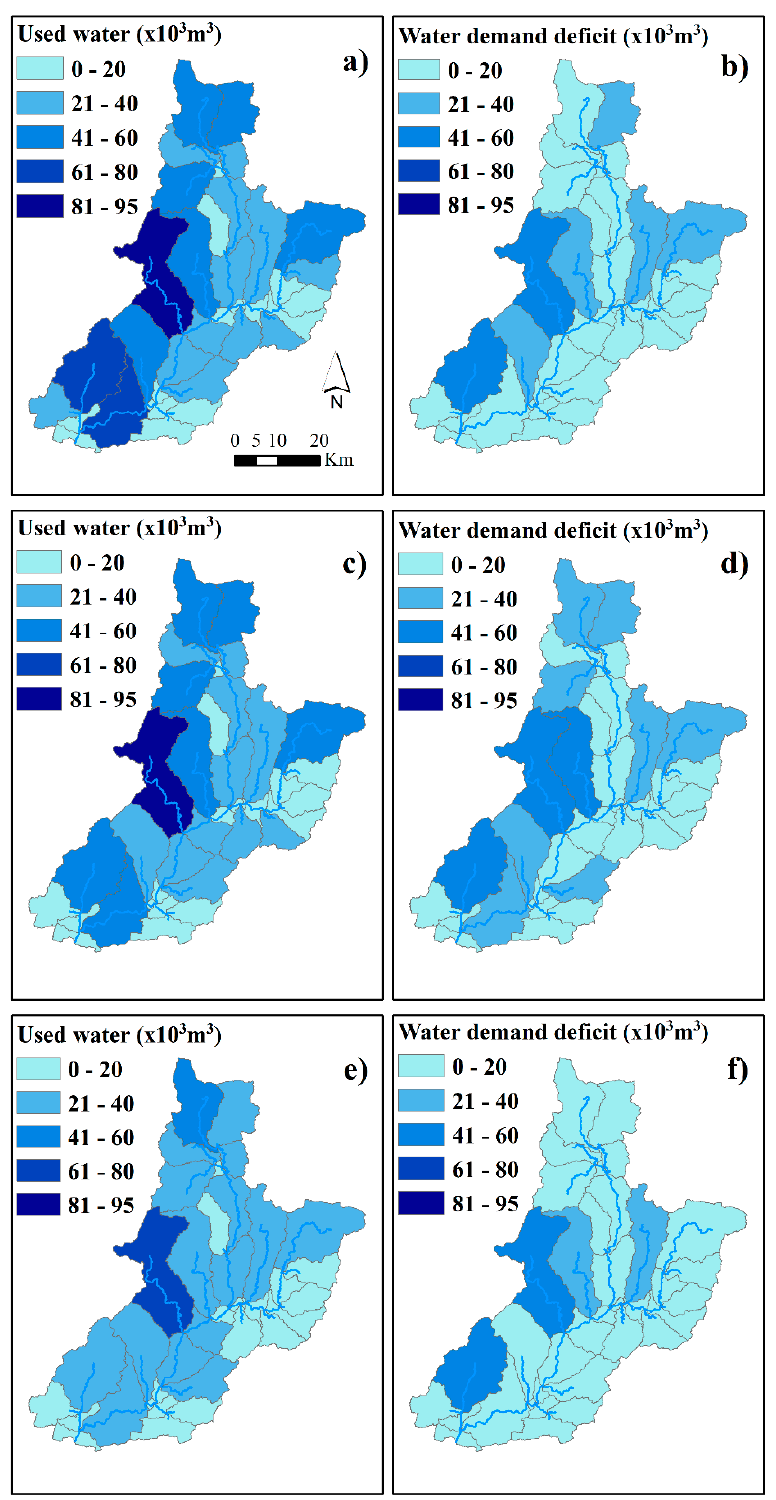
Figure 7. The water used for domestic consumption and the water demand deficit at the sub-basin scale in the Sabor River basin. ( a ) and ( b ) represent the water used for domestic consumption and the water demand deficit in the historical view, respectively. The figures ( c ) and ( d ) represent the data on the increase in the irrigated area, and ( e ) and ( f ) represent the data on the scenario of a projection to 2060.